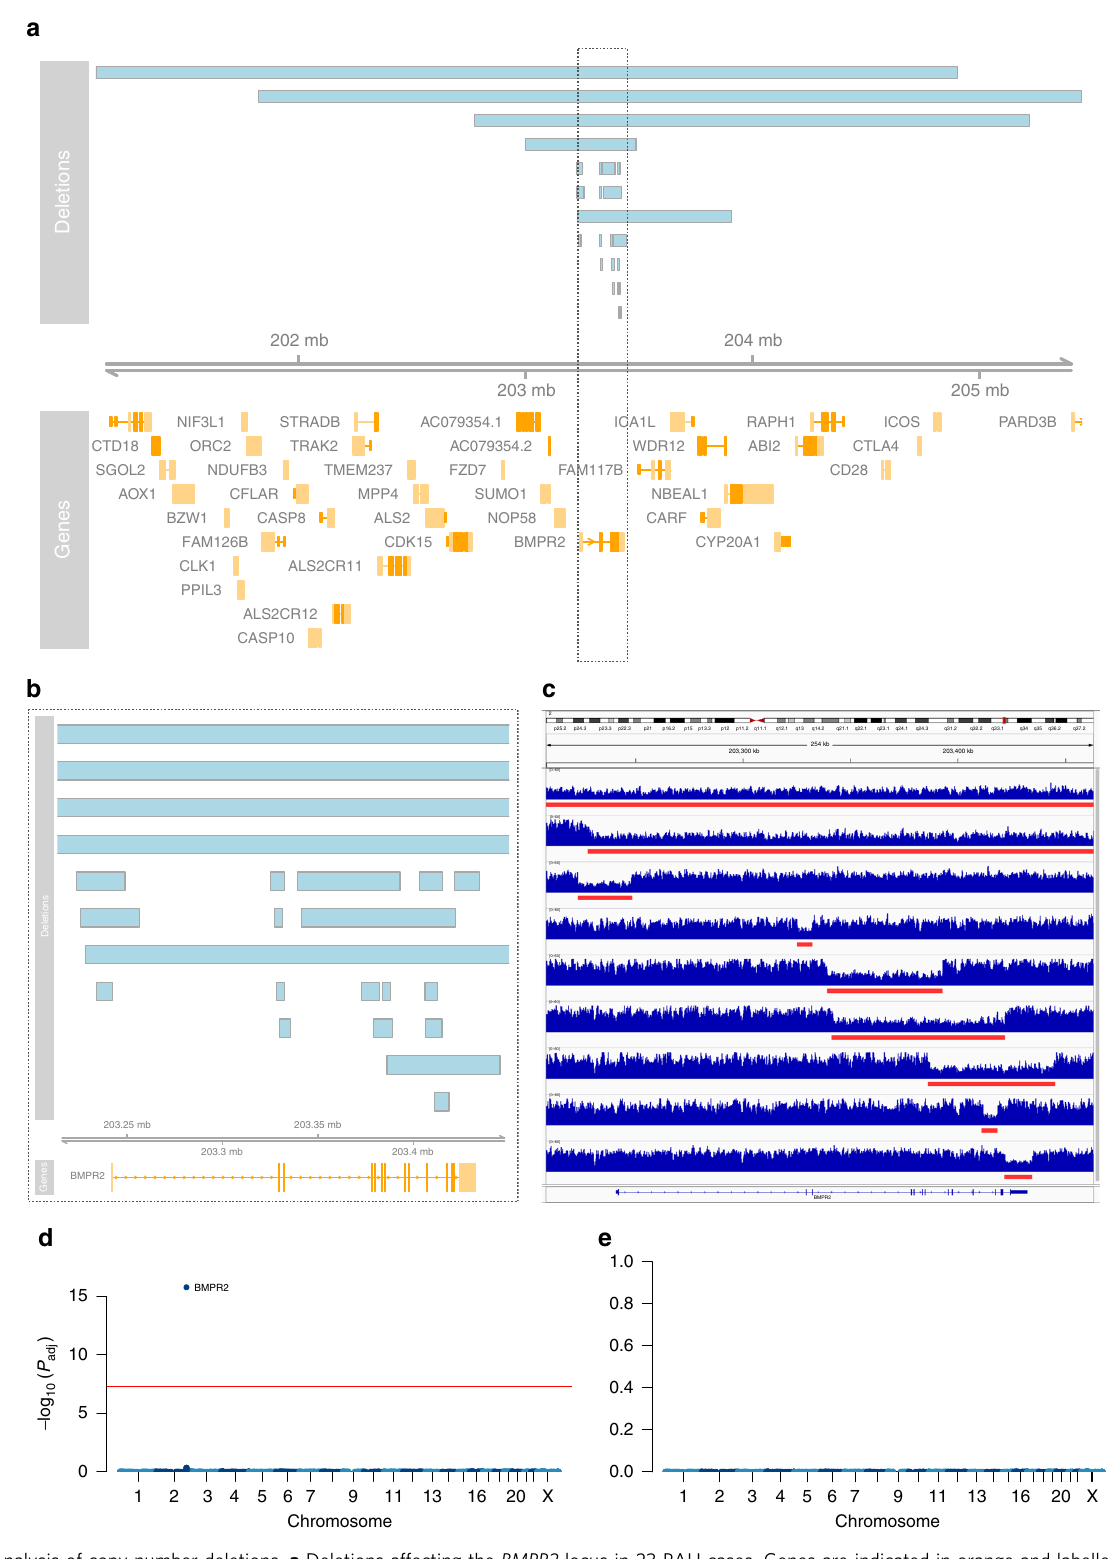
Fig. 2 Analysis of copy number deletions. a Deletions affecting the BMPR2 locus in 23 PAH cases. Genes are indicated in orange and labelled with their respective gene symbol. Deletions are drawn as blue boxes above the genome axis (grey) showing the genomic position on chromosome 2. The grey box highlights the location of BMPR2 . b Locus zoom on BMPR2 highlighting the focal deletions affecting one or more exons. c WGS coverage pro fi les of a selected set of smaller and larger deletions, visualised with the Integrative Genomics Viewer (IGV) 57 , with deletions highlighted by red bars. d and e Manhattan plots of the genome-wide case-control comparison of large deletions. In d , all subject are considered. In e , subject with larger deletions affecting the BMPR2 locus are excluded. The adjusted P value threshold of 5 × 10 − 8 for genome-wide signi fi cance is indicated by the red